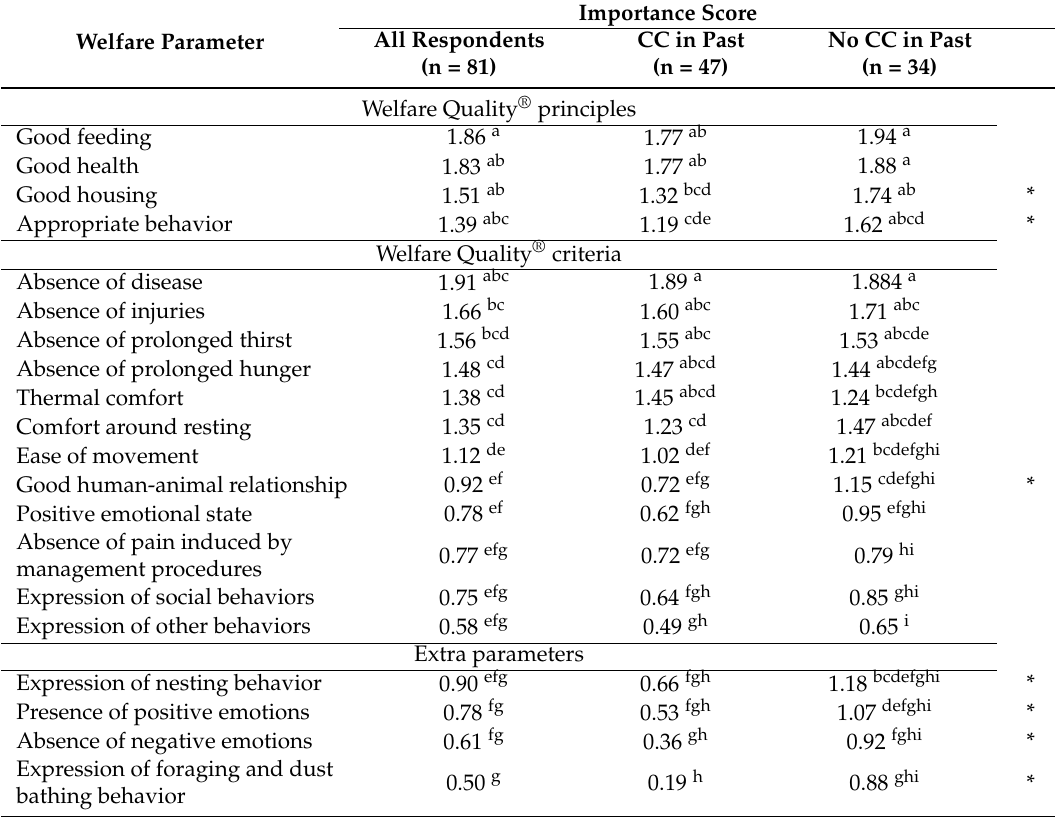
Table 2. Least squares mean importance scores (on a scale from important) of welfare parameters according to all respondents; and presented based on whether farmers had conventional cages in the past (n =